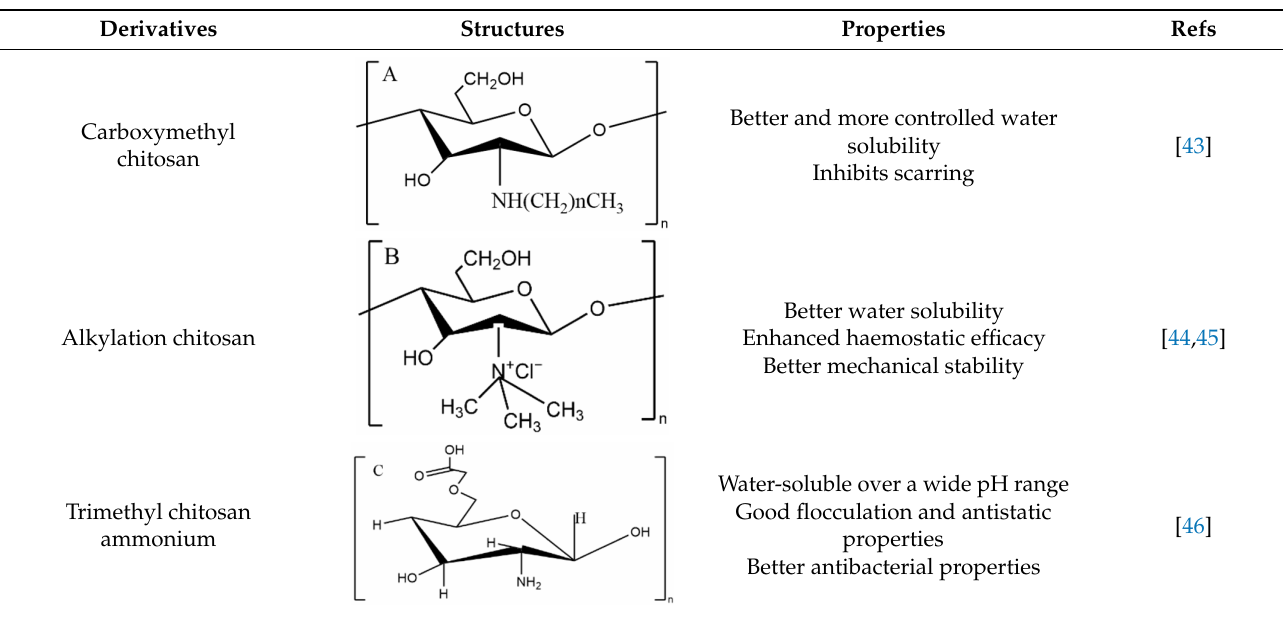
Figure 4. Chemical structure of chitin ( A ) and chitosan ( B ) fragments. Table 2. The most common CS derivatives used in biotechnology